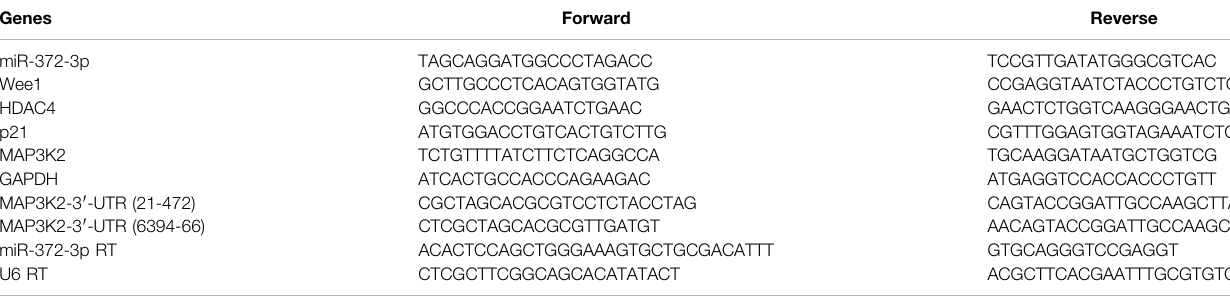
TABLE 1 | Sequence primers designed for real-time